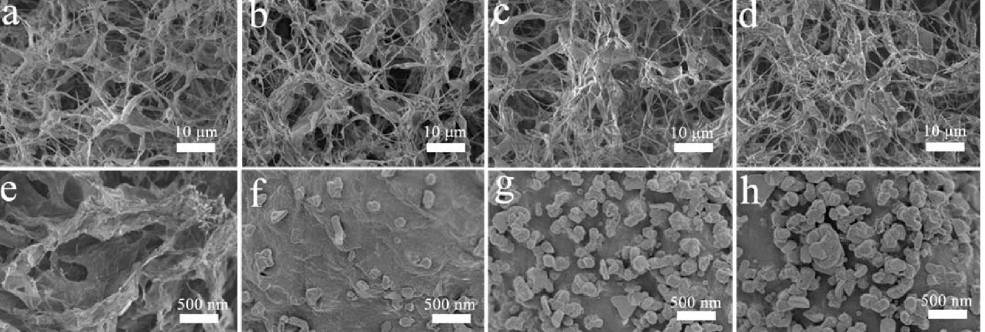
Figure 11. SEM images of the aerogel composites: ( a , e ) MFCAs, ( b , f ) HMFCA-1, ( c , g ) HMFCA-2, ( d , h ) HMFCA-3. Reprinted with permission from [25]. Copyright ©2016 American Chemical Society.